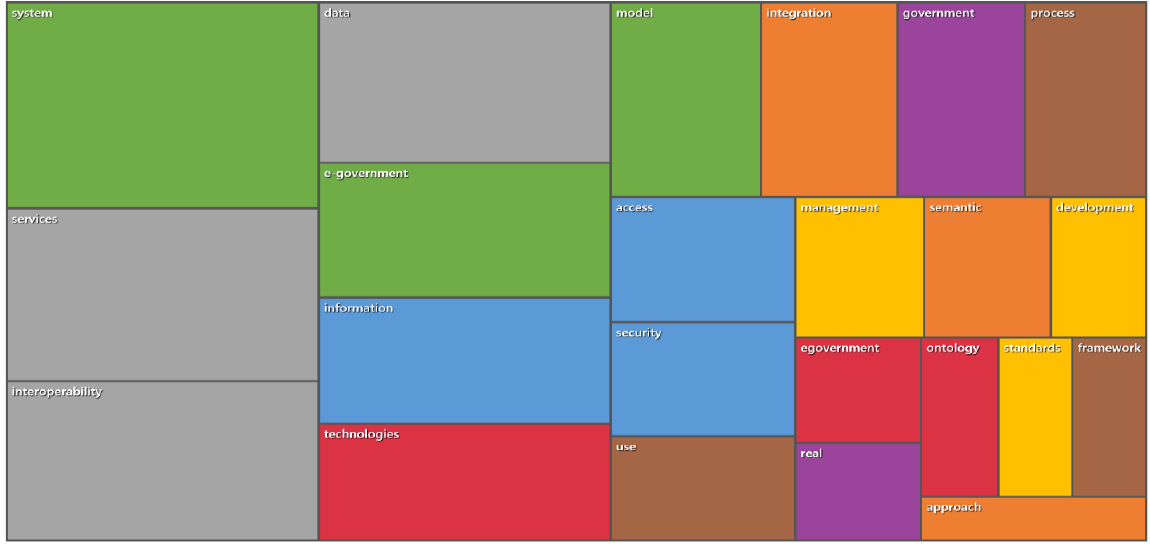
Figure 8: Dominant Study Themes in of E-Government Interoperability. Source: Processed by the author using Nvivo 12 Plus.